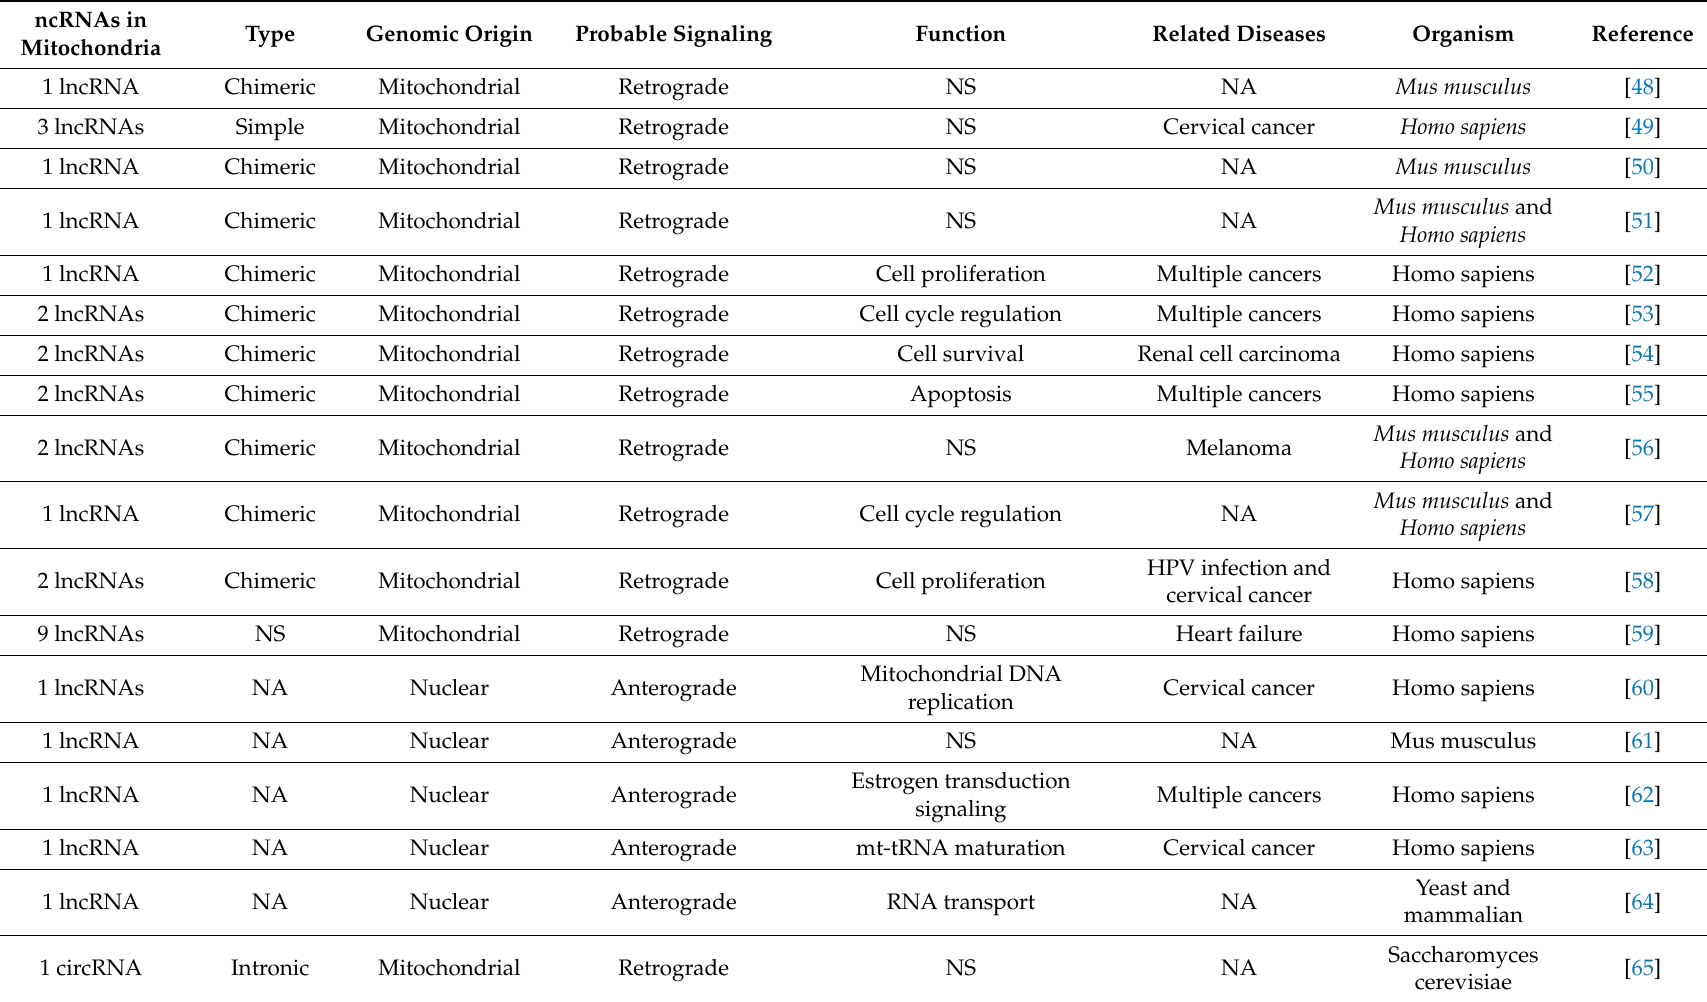
Table 1. Characterization of nuclear-ncRNAs and mt-ncRNAs and their related diseases and